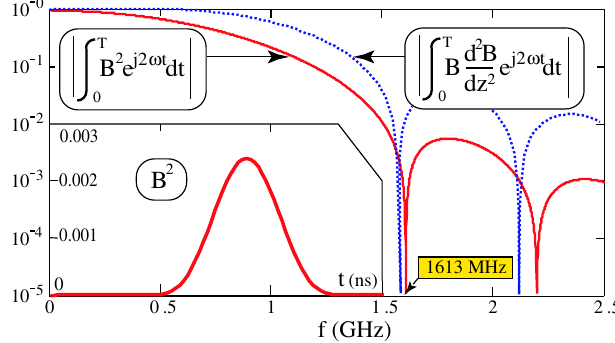
FIG. 6. (Color) TE mode axis fields, frequencies, and the Fourier cell rf gun [9] with separated focusing TE transform for the 1 1 2 mode having the resonance of 1613 MHz shown in Fig. 3 ( (cid:2) (cid:4) const ). The dotted line dependence is analyzed in the next chapter.